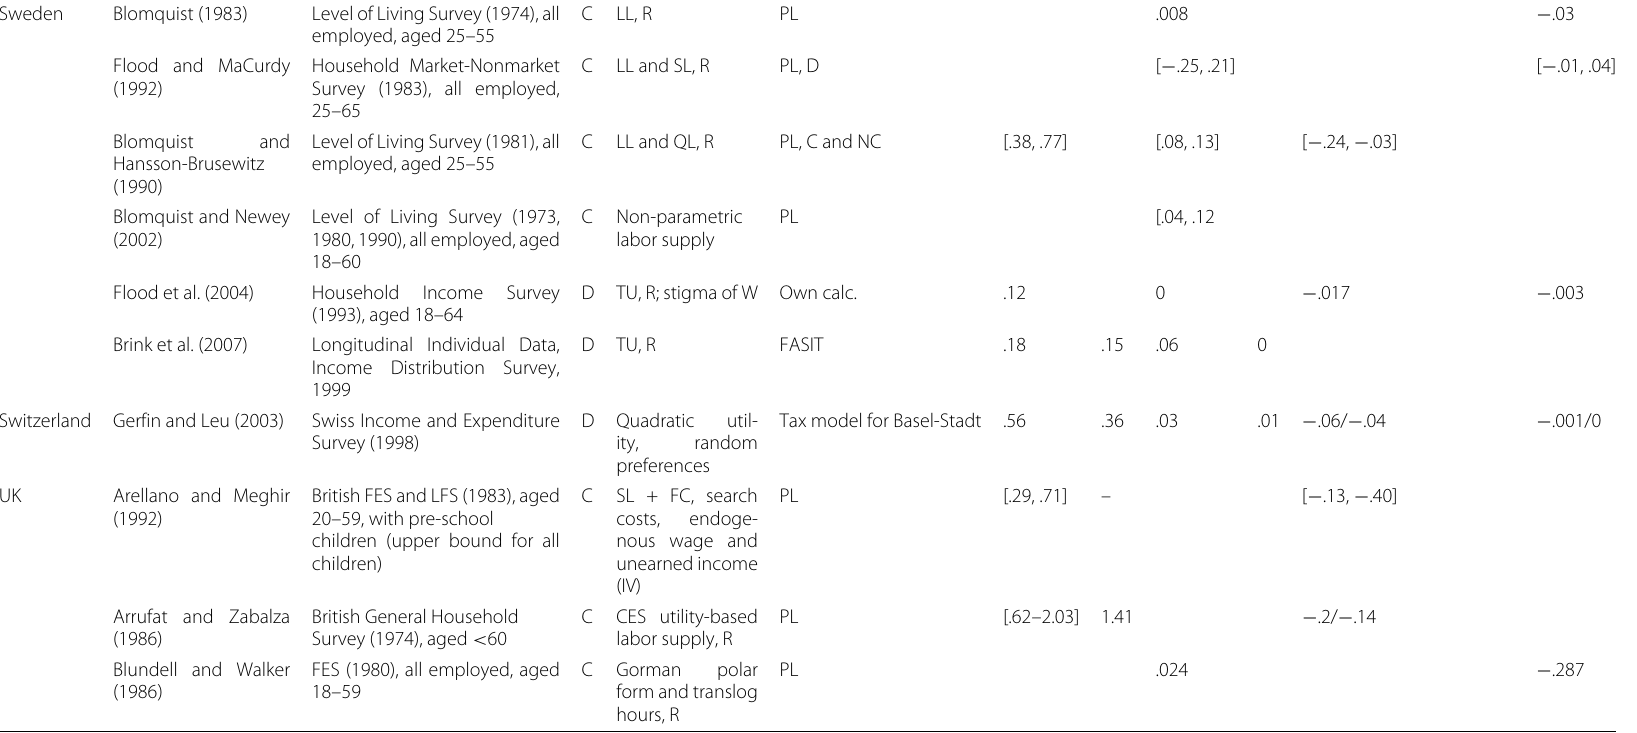
Table 1 Labor supply elasticities in Europe: couples